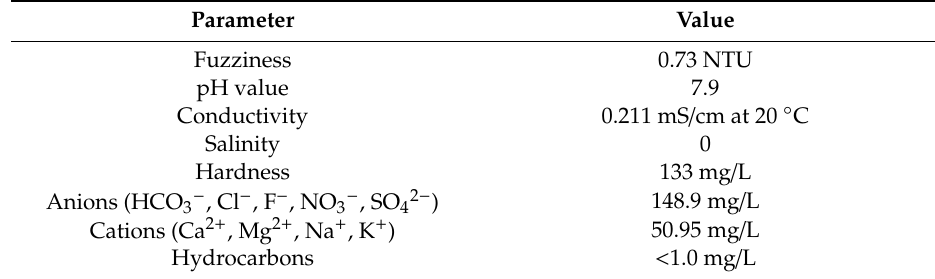
Table 1. General chemical properties of the tap water of the city of Rijeka. All samples were taken from public water supply and analysed.